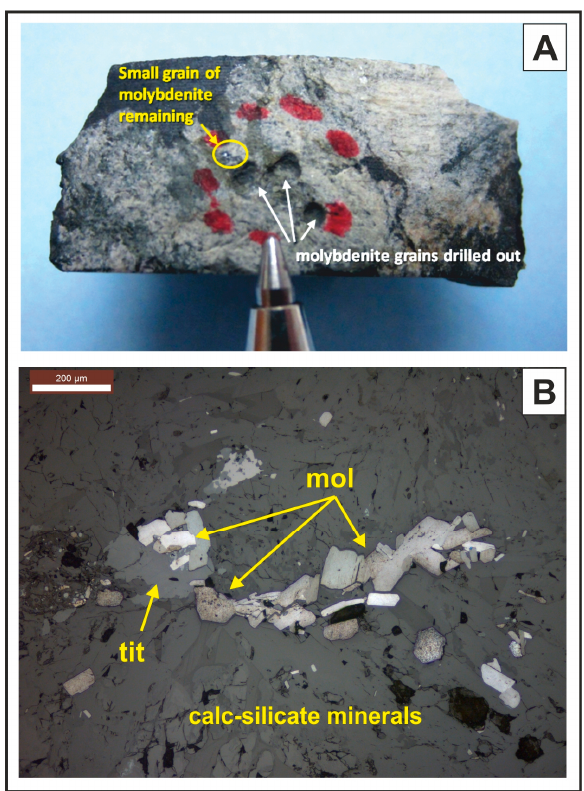
Figure 8. Molybdenite samples from the Palokas ( A ) and Rompas ( B ) properties. Molybdenite flakes (mol) on the photograph “B” show different shades of grey because of the strong bireflectance under incident polarized light in the microscope. Table 2. Re–Os data (TIMS) for molybdenite samples from the Rompas and Palokas